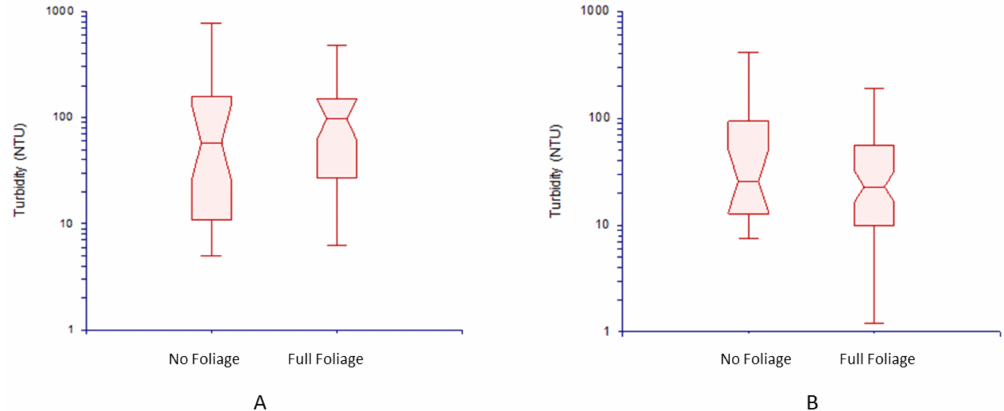
Figure 11. Turbidity Response to Change in Foliage: Turbidity data at loggers were analyzed to determine the influence of seasonality, based on the presence of foliage, at Chelten Hills ( A ) and Mill Run ( B ). While the mean turbidity does increase at both sites when no foliage was present, this change was not found to be significant at either